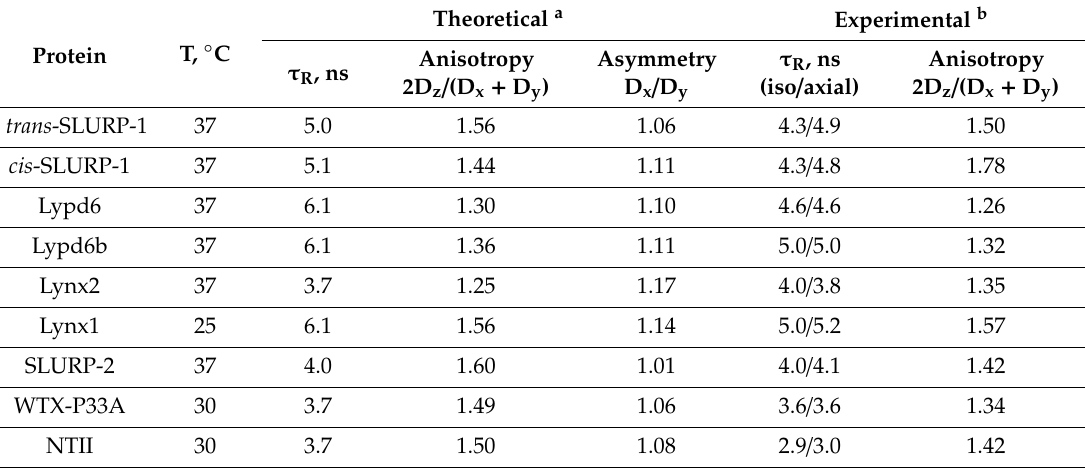
Table 2. Rotational di ff usion of TFPs in